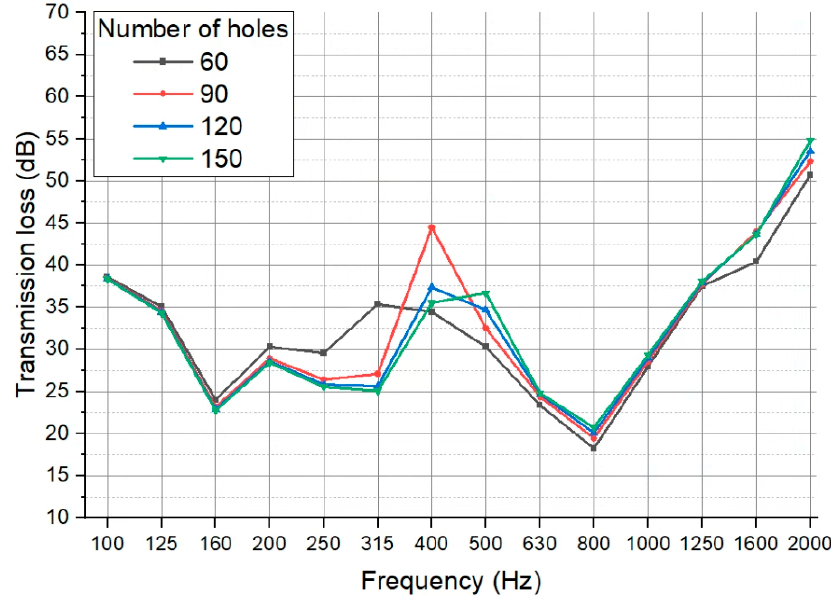
Figure 24. Transmission loss according to the number of holes in the inner resonate type.